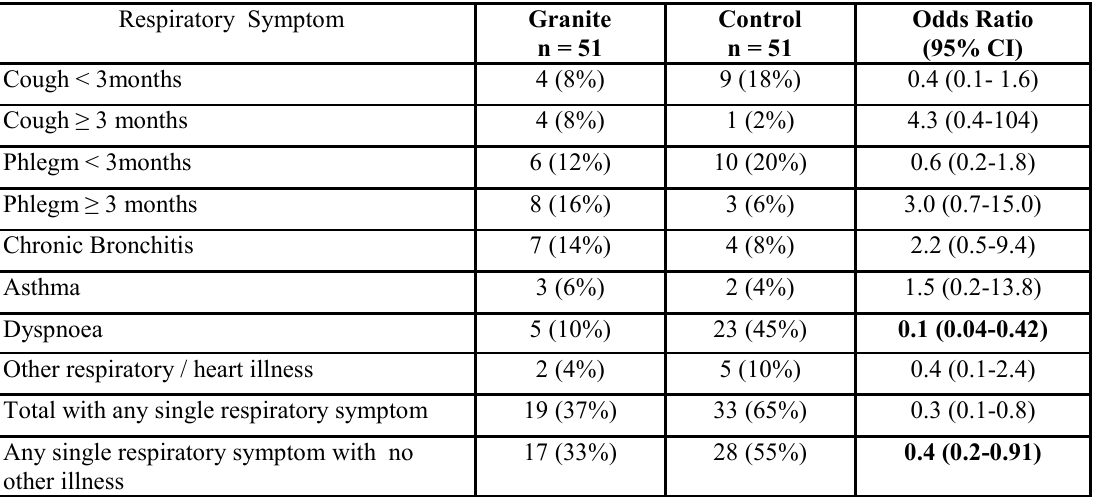
Table 2 - Comparison of respiratory symptoms in the two groups